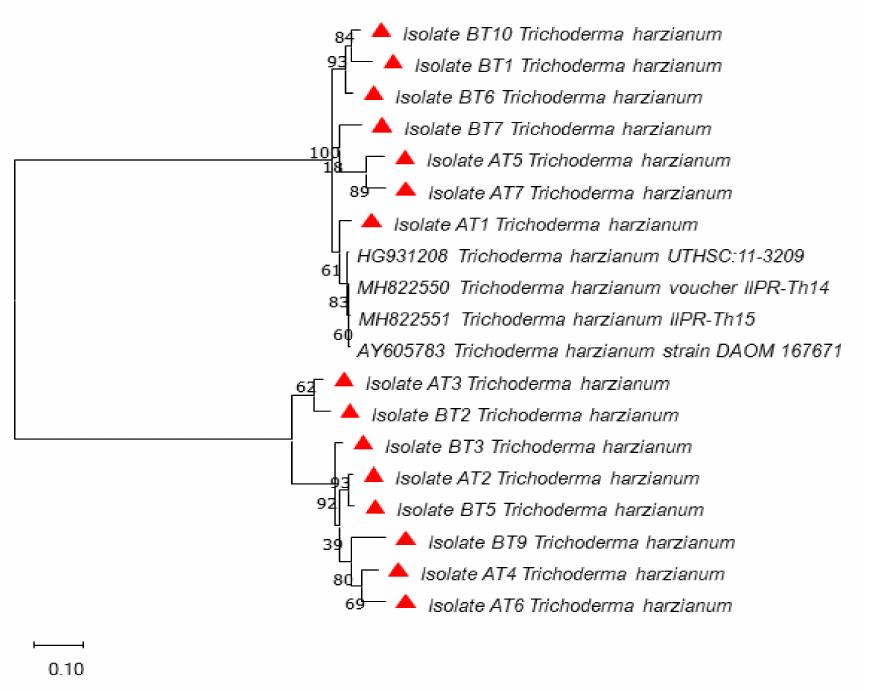
Figure 2. Phylogenetic relationship of Trichoderma harzianum using the region tef 1 α (Translation elongation factor-1 α ) gene nucleotide sequence alignment using maximum likelihood method at 1000 replications for each bootstrap value using the MEGA 10.0, symbols red triangles in phylogeny represents our isolates. Table 2. Effect of colloidal chitin concentration on chitinase activity of Trichoderma isolates. Chitin Concentration Isolates